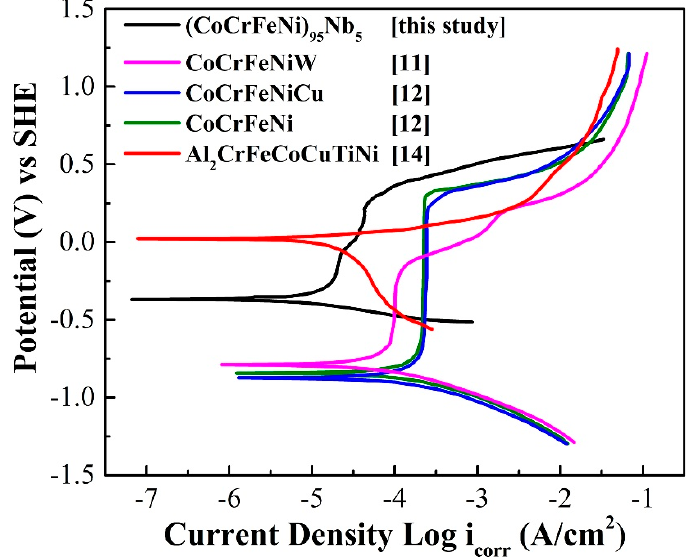
Figure 6. Polarization curves of (CoCrFeNi) 95 Nb 5 HEA coating and the reported HEA coatings in 3.5 wt.% NaCl solution.